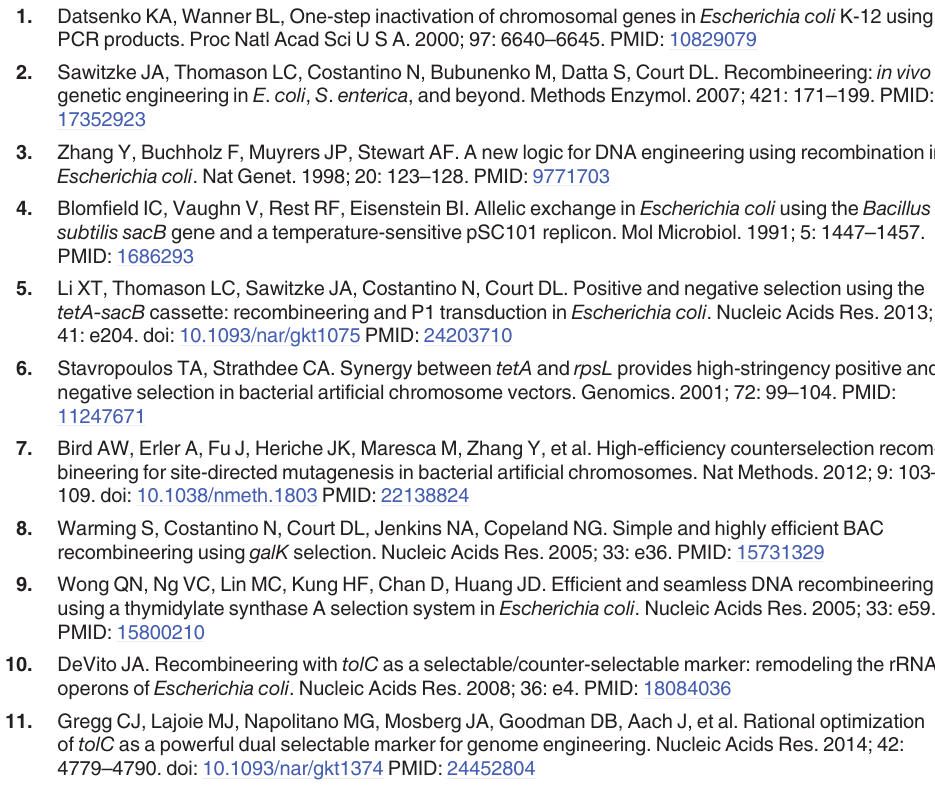
S4 Table. Genotype summary of non-fluorescent clones found in the first round of recom- bineering. From the first round of two-step recombination using the HK cassette (Table 2), nine clones without GFP mut3.1 fluorescence were individually picked and analyzed in their lacZ (or Δ lacZ :: hsvTK-km r ) locus. For the sequence of primers used for PCR amplification and se- quencing (primers P30, 33, P43, and P44), see S1 Table. S5 Table. Mutations found in hsvtk regions of the counter-selection escapees arose during the overnight growth of a dP sensitive strain MG1655 Δ lacZ :: hsvTK-km r . dP sensitive clone was cultured overnight and plated on dP-selection plates. From these plates nine clones were picked and sequenced in their hsvtk coding